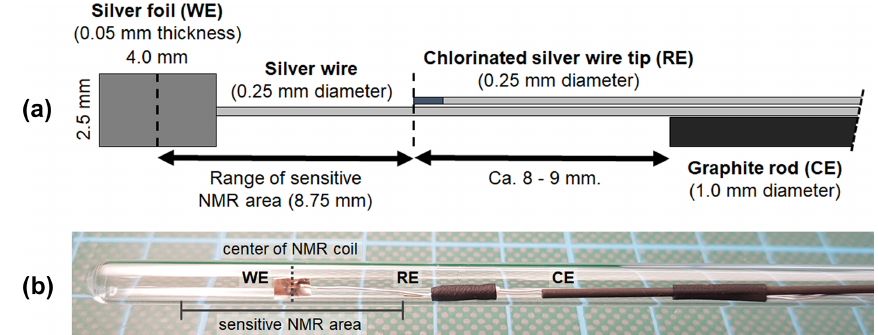
Figure 1. (a) Geometry and arrangement of the three-electrode in operando NMR setup. It consists of a silver foil working electrode (WE), a graphite rod counter electrode (CE), and a micro Ag / AgCl reference electrode (RE). The reference electrode was placed on the edge of the sensitive NMR area to minimize the amount of conductive material during NMR measurements while maintaining a small ohmic potential drop between the working and reference electrodes. (b) Photograph of the electrode setup inside a 5mm tube.